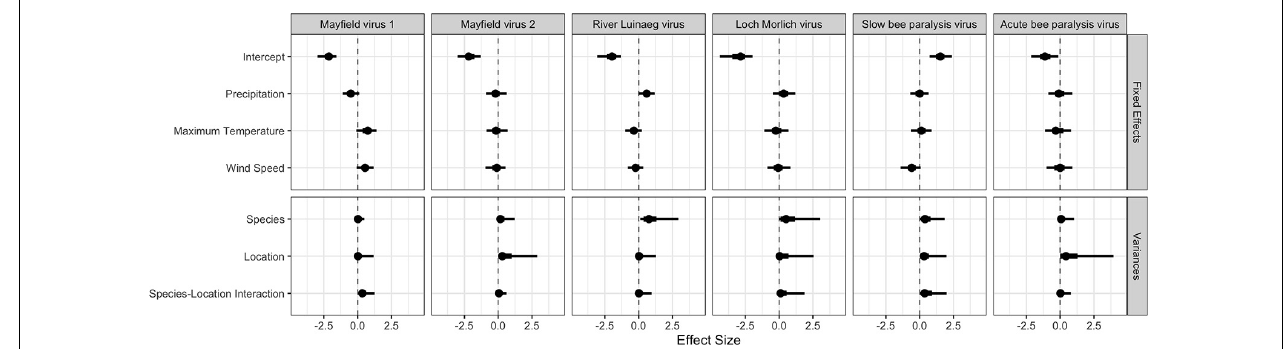
FIGURE 4 | The estimates for each parameter in each virus from the multivariate probit model. The point estimate is the posterior mode, with 50% shortest posterior intervals represented by the thick lines and 90% shortest posterior intervals represented by the thin lines. Shortest posterior intervals are a continuous credible interval (measured on the scale of the parameter) that contains 90% of the posterior density, that is an interval which has a 90% chance of containing the correct parameter value under the model, the data and the priors. TABLE 3 | The Morisita-Horn dissimilarities of the bumblebee compositions of the different sampling sites.